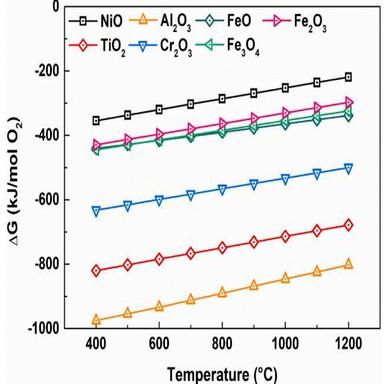
Gibbs free energy changes of different oxidation reactions.